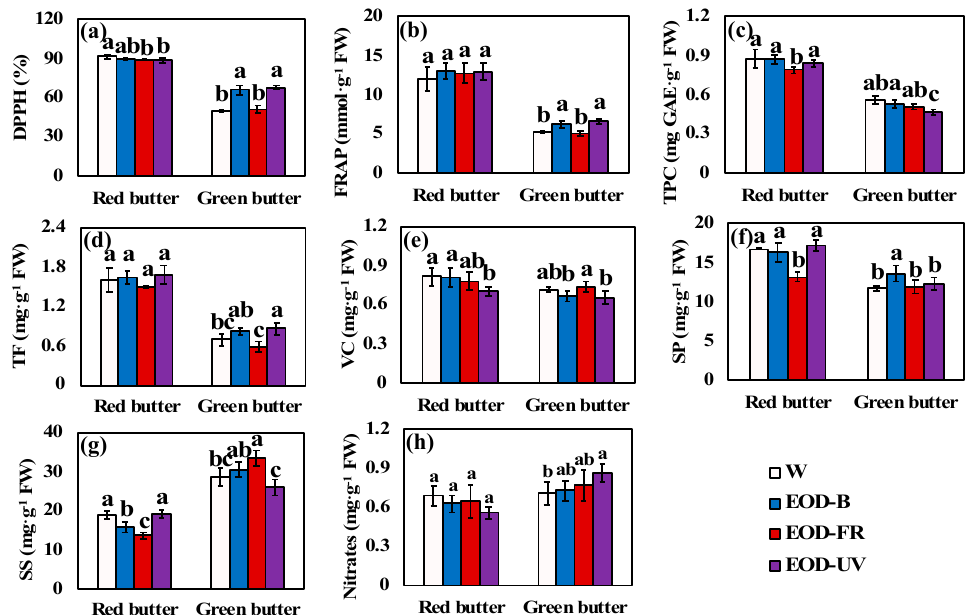
Figure 7. Phytochemical contents of lettuce under di ff erent end-of-day lightings. ( a – e ) were the contents of antioxidant compounds. ( f – h ) were the contents of nutrient compounds. Di ff erent letters on the top of the columns indicate significant di ff erences at p < 0.05 according to one-way ANOVA, Tukey’s honest significant di ff erence tests. W = day-white light, EOD-B = end-of-day enhanced blue light, EOD-FR = end-of-day far-red light, EOD-UV = end-of-day ultraviolet-A light. FW = fresh weight, DPPH = DPPH radical inhibition percentage, FRAP = ferric ion reducing antioxidant power, TPC = total phenolic compounds, TF = total flavonoids, VC = vitamin C, SP = soluble proteins, SS = soluble sugars. Table 5. The interaction effects of cultivars and lightings on lettuce phytochemical contents. Interaction